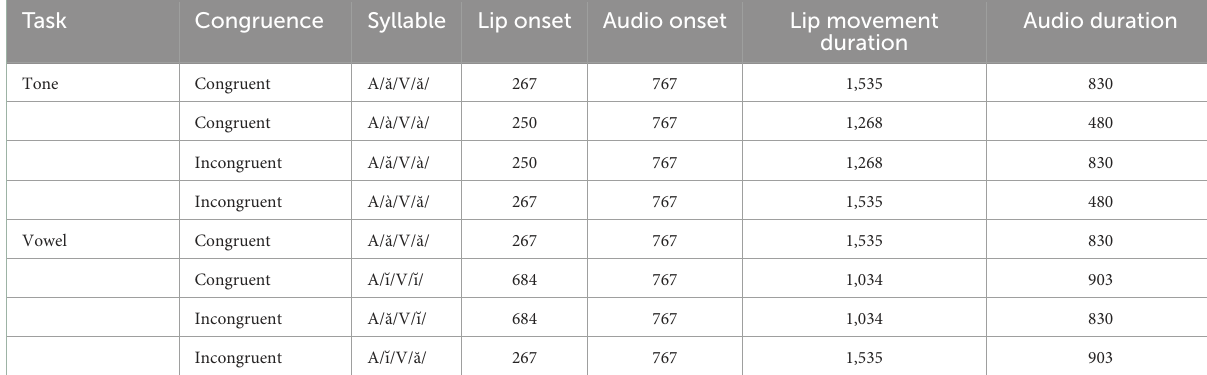
TABLE 1 The duration of the audiovisual stimuli, corresponding to auditory, and visual components and onset times (in ms). Task Congruence Syllable Audio